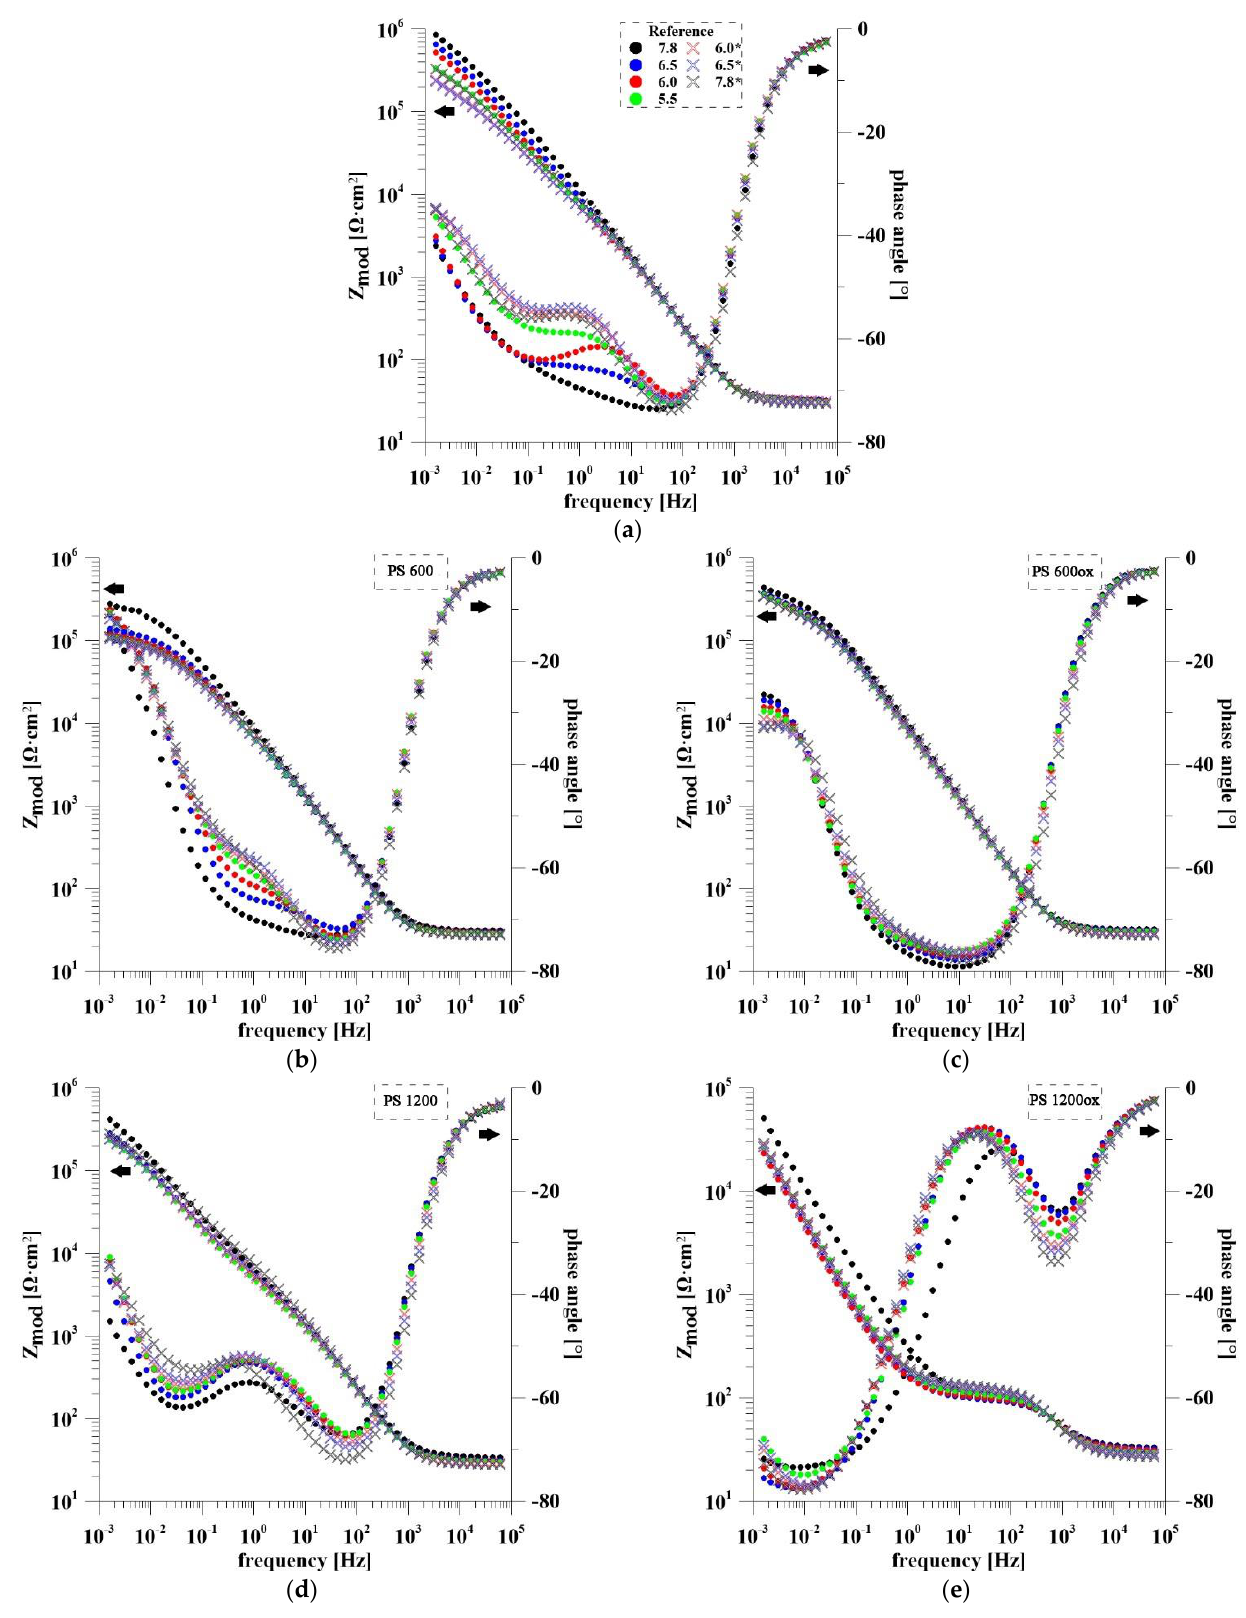
Figure 6. EIS spectra of all samples in physiological solution during pH changing: ( a ) Reference sample; ( b ) PS 600; ( c ) PS 600ox; ( d ) PS1200; ( e ) PS 1200ox.